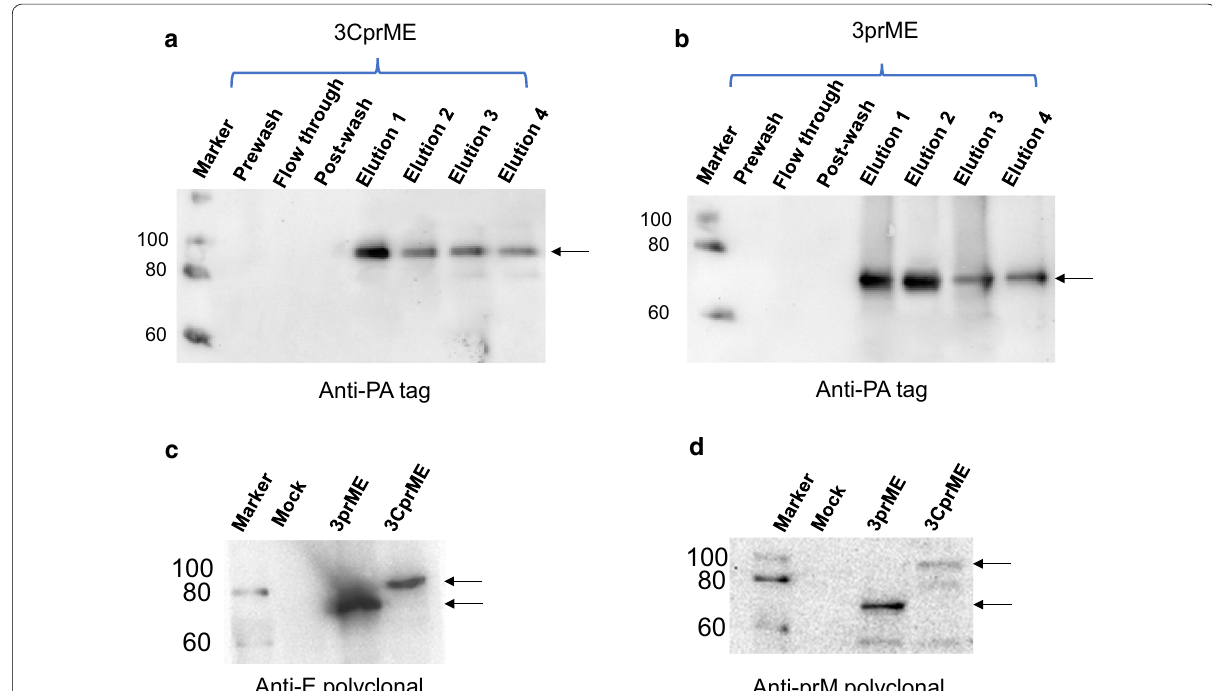
Fig. 3 Western blot of purified 3CprME ( a ) and 3prME ( b ) polypeptides. Each protein was purified from silkworm larvae fat body using PA-tagged protein purification gel column chromatography. The E and prM were verified using rabbit anti-E protein polyclonal ( c ) and rabbit anti-prM protein polyclonal ( d )